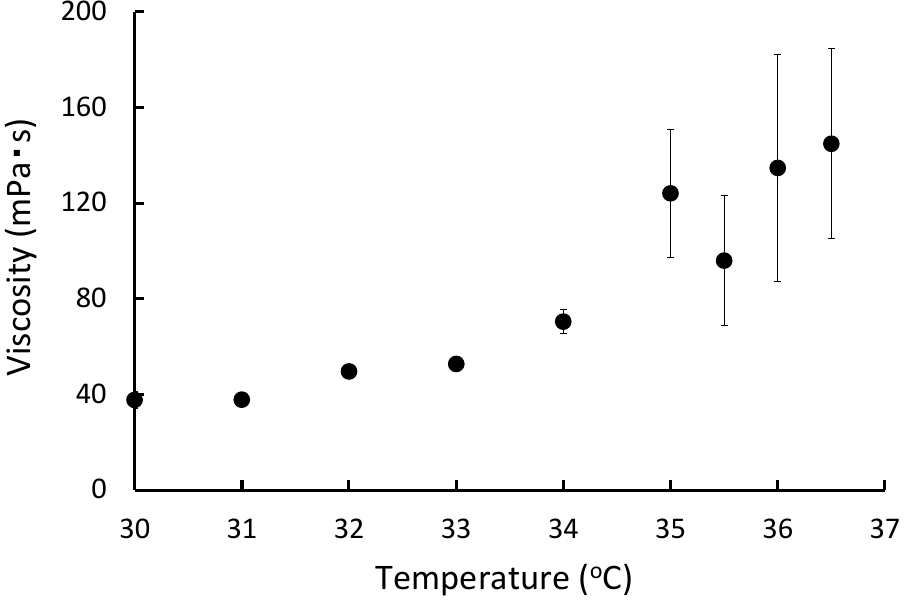
Figure 2. Viscosity evaluation of temperature-sensitive gel against temperature changes. A glass tube was filled with temperature-sensitive gel and placed in a temperature-controlled water bath for 10 min. A 5/32-inch steel ball was dropped from the top, and the time taken for the ball to fall 10 cm was measured. Viscosity was calculated using Stokes’s law. Data are expressed as the mean ± SEM of n = 3–5.